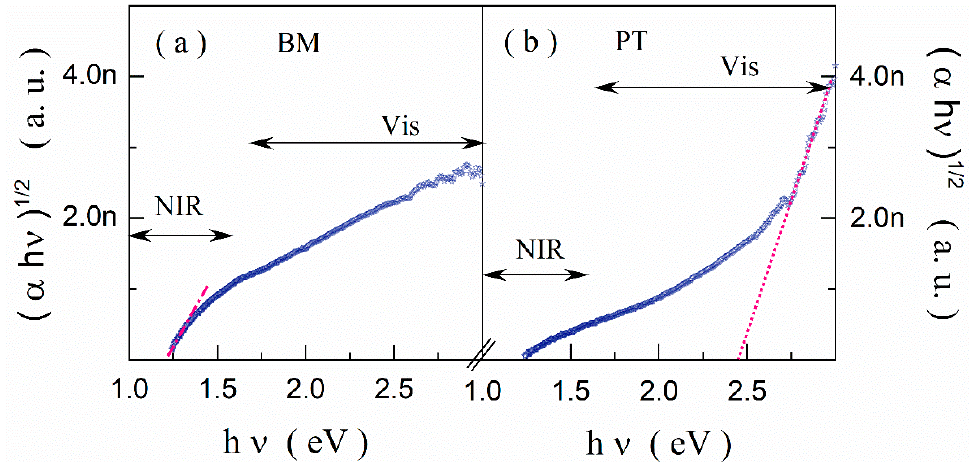
(Figure 9b). Figure 8. Reflectance, R , vs. wavelengths, λ , dependence measured for BM ( a ) and PT ( b ).